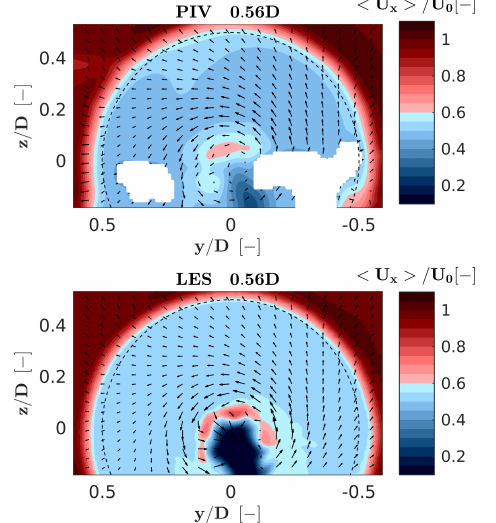
Figure 4. Streamwise velocity contours for the CS LES model and PIV experimental measurements, on a plane 0.56D downstream of the rotor. Black arrows indicate the crosswind velocity component at a number of sampling